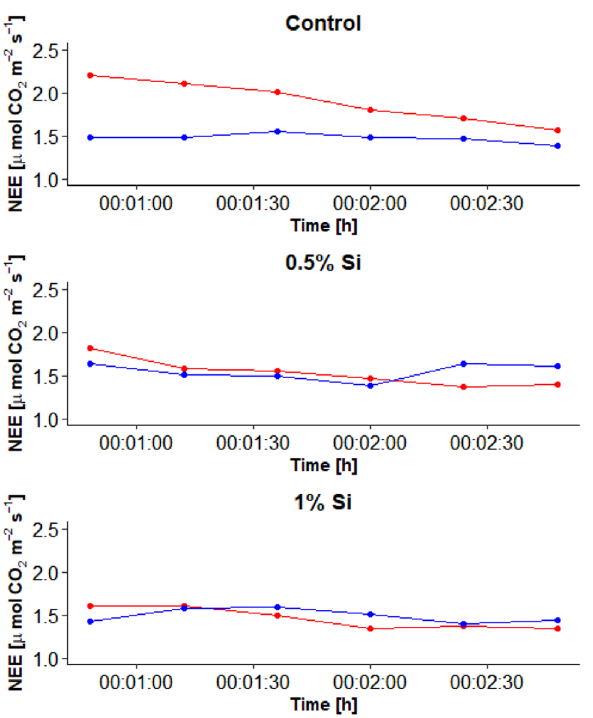
Figure 5. Net ecosystem exchange (NEE) data for the different treatments (control, 0.5% ASi and 1% ASi) at different time points prior (blue) and after shading (red). Data from chamber